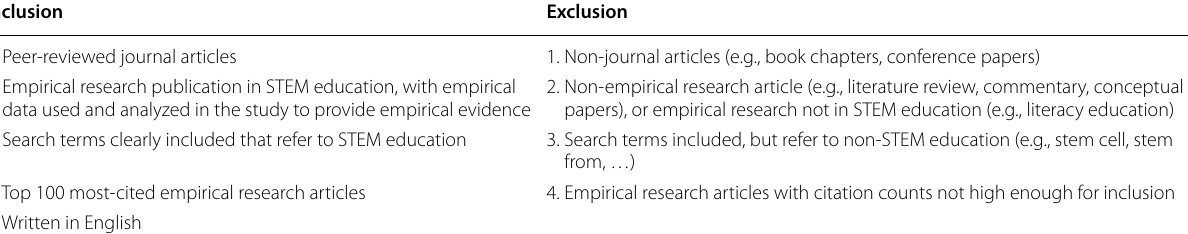
Table 2 Inclusion and exclusion